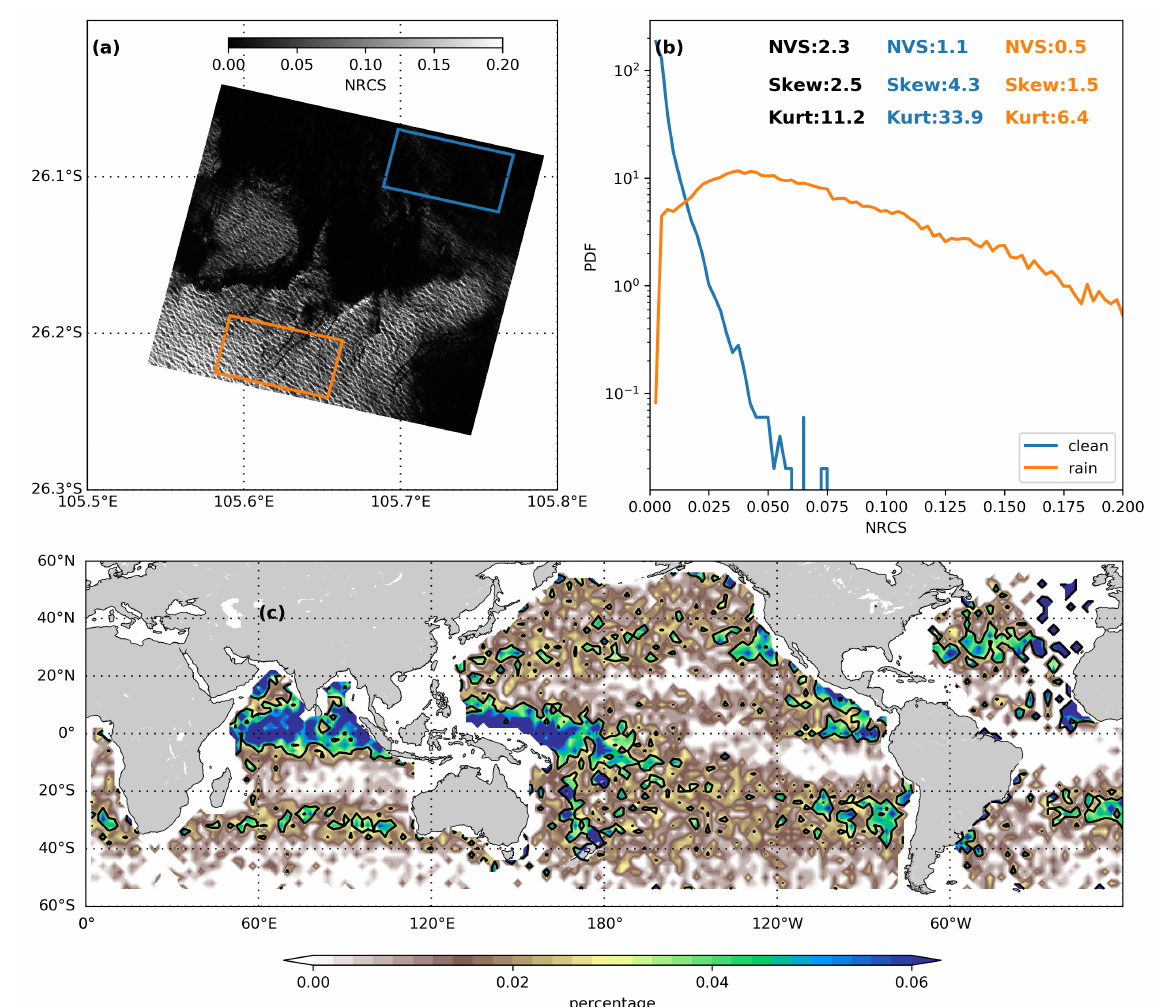
Figure 8. ( a ) A SAR NRCS image of a low wind area at WV1; ( b ) the NRCS PDFs over the area of interest marked by the rectangles in colors as well as the entire SAR image (black curve). The three statistical parameters are accordingly annotated in the plots. ( c ) Global percentage map of the detected low wind area using the Nvar-based criteria for